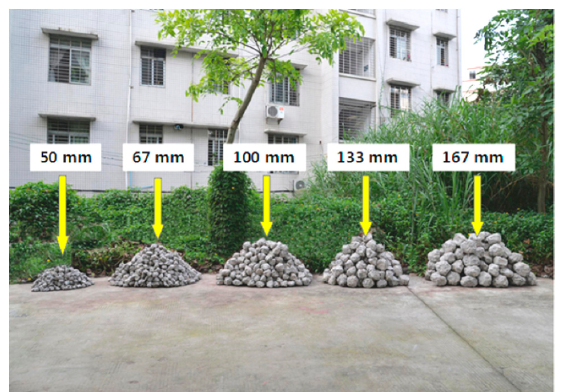
Figure 3. Five piles of demolished concrete lumps (DCLs).